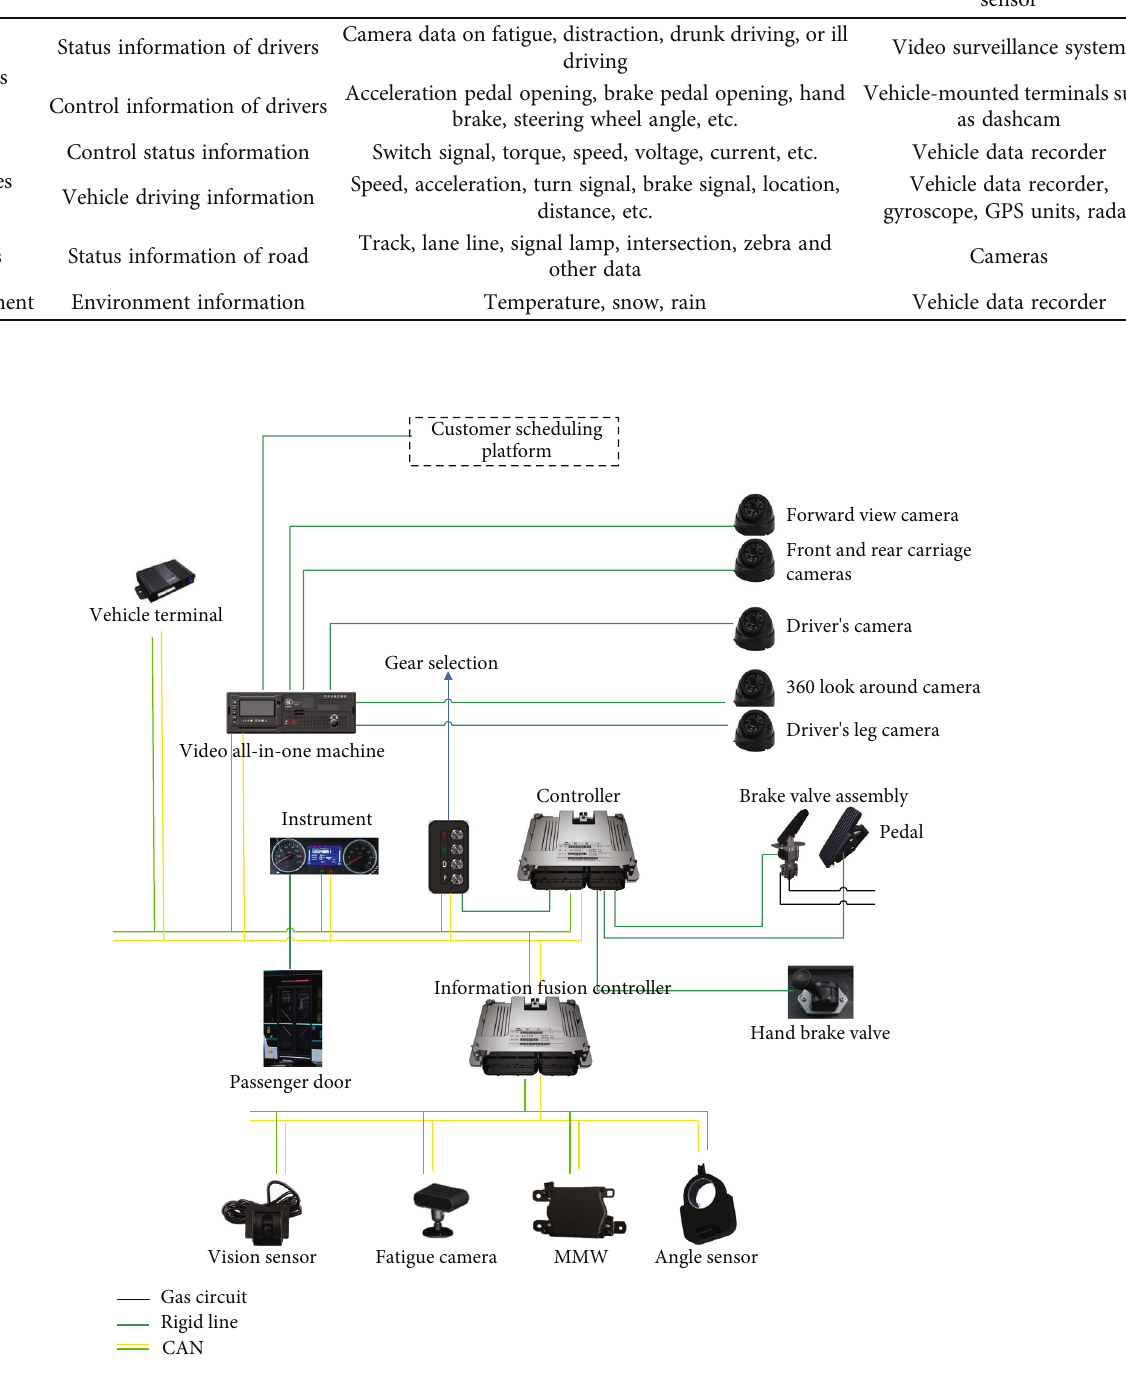
Figure 2: The schematic diagram of onboard CAN bus